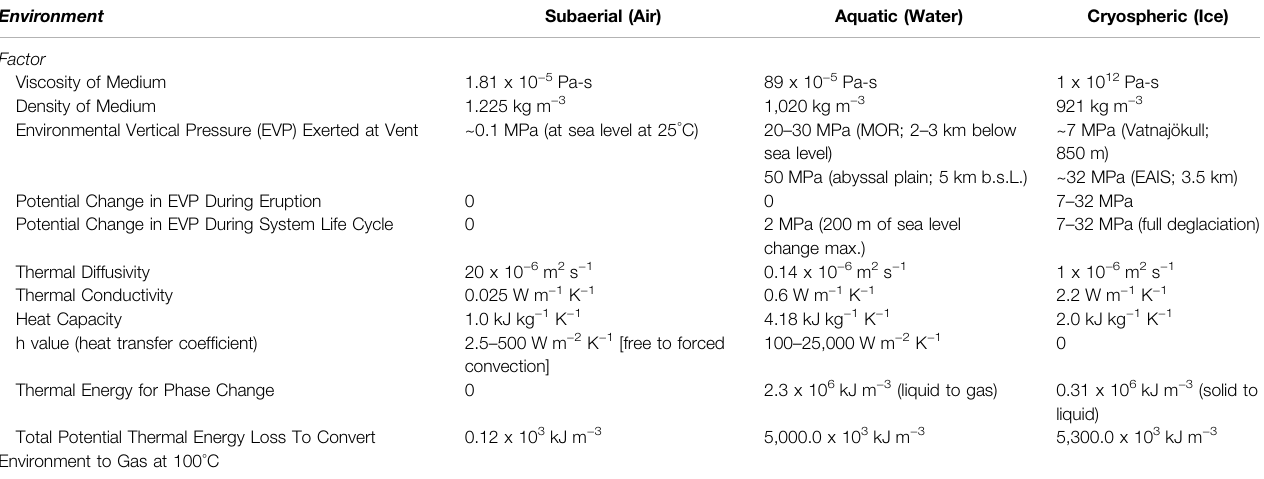
TABLE 1 | Important physical parameters of eruption environment media.